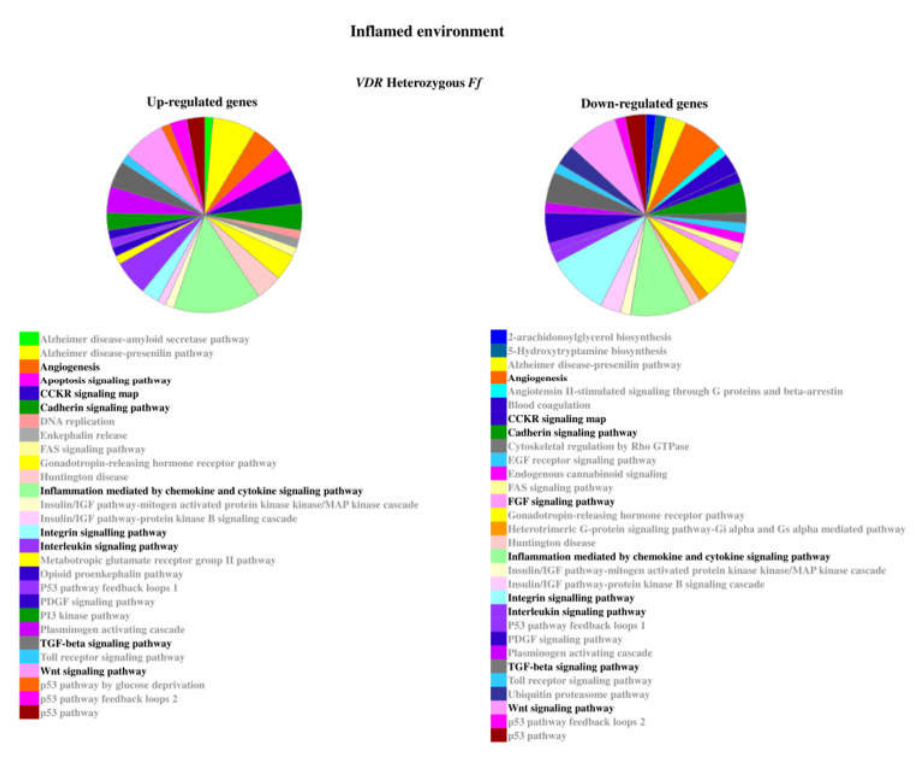
Figure 6. Pathways associated to the genes modulated by inflammatory stimulus in heterozygous Ff disc cells. Relevant pathways are highlighted in black bold. Pie chart obtained by Panther.